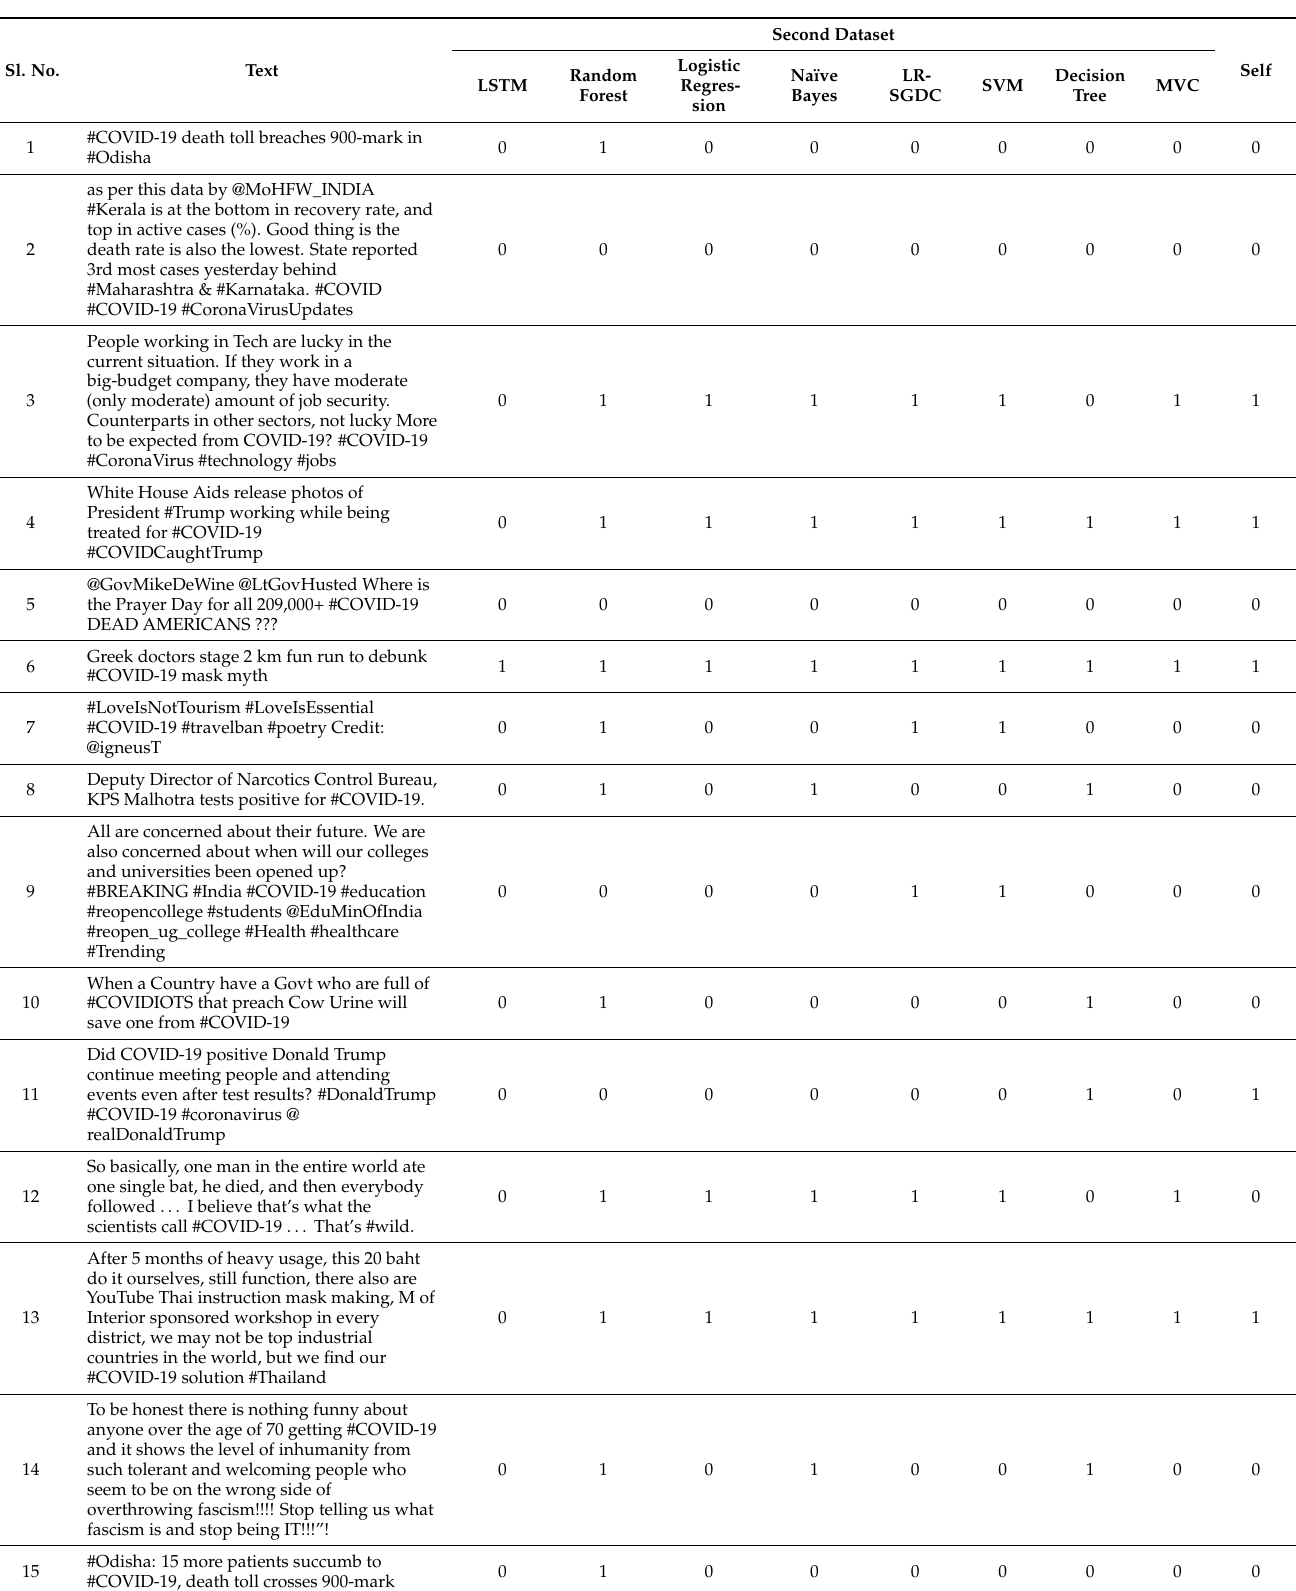
Table 9. Prediction of mined tweets by the various classifiers trained with the second